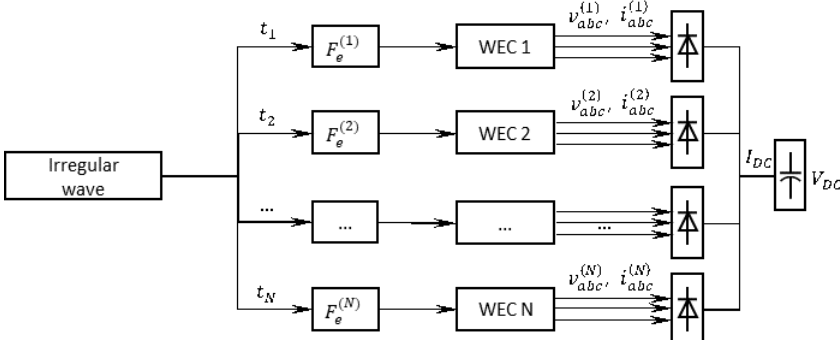
Figure 7. Schematic of wave to DC-link wave power farm model. Reproduced with permission from